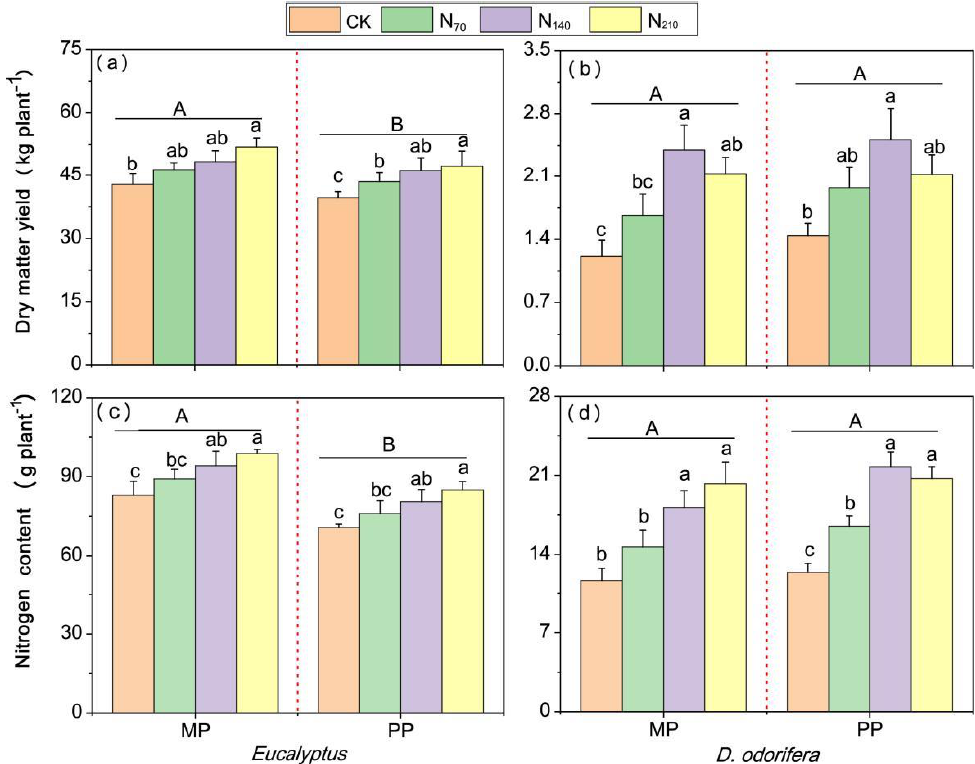
Figure 9. The effects of N application and planting system on the DM yield of and N content in mixed and pure E. urophylla × grandis and D. odorifera plants. CK indicates control plants without N application; N 70 , N 140 and N 210 correspond to N fertilizer application rates of 70, 140 and 210 kg urea (CO( 14 NH 2 ) 2 ) ha − 1 , respectively. ( a , b ) represent the DM yield of E. urophylla × grandis and D. odorifera , respectively. ( c , d ) represent the N content of E. urophylla × grandis and D. odorifera , respectively MP = E. urophylla × grandis mixed together with D. odorifera plantations; PP = pure plantations. The different lowercase letters above the bars indicate significant differences ( p < 0.05) in whole-plant DM accumulation among N treatments within each planting system. The different capital letters on the straight lines indicate significant differences in E. urophylla × grandis or D. odorifera between mixed and pure plantations ( p < 0.05). There was no significant N level × planting system interaction effect on the DM yield of or N content in either species. Error bars indicate ± SE ( n = 3).